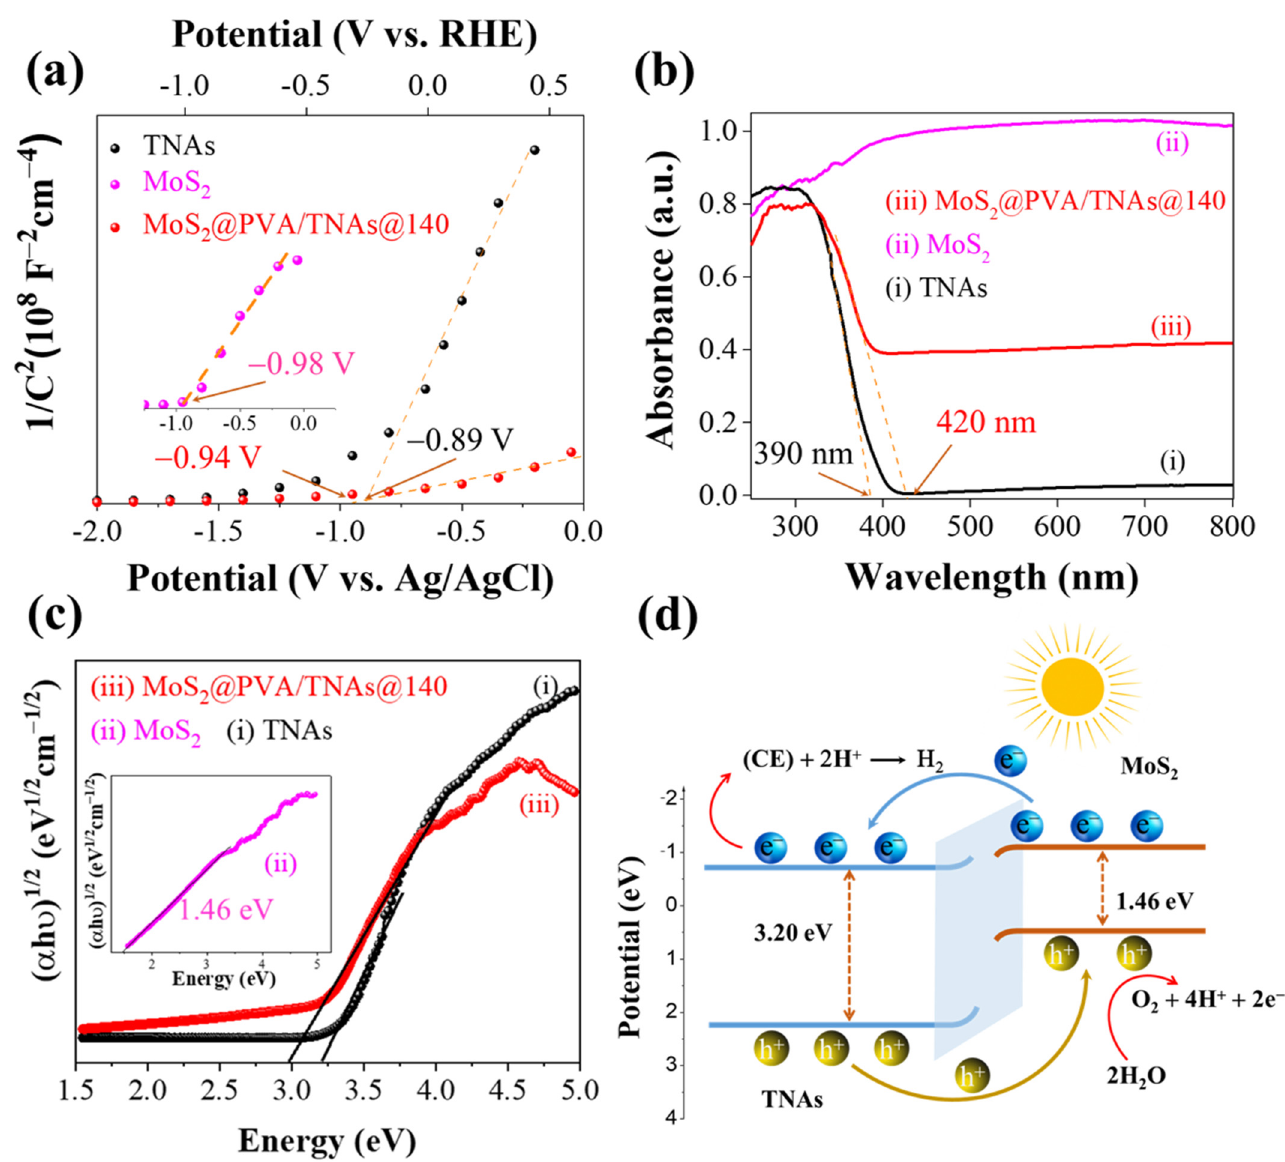
Figure 7. Mott–Schottky plots ( a ), DRS spectra ( b ), Tauc plots ( c ) of MoS 2 , TNAs, and MoS 2 @PVA/TNAs@140 and the proposed schematic illustration for the energy band alignment of the MoS 2 /TNAs heterojunction ( d ).